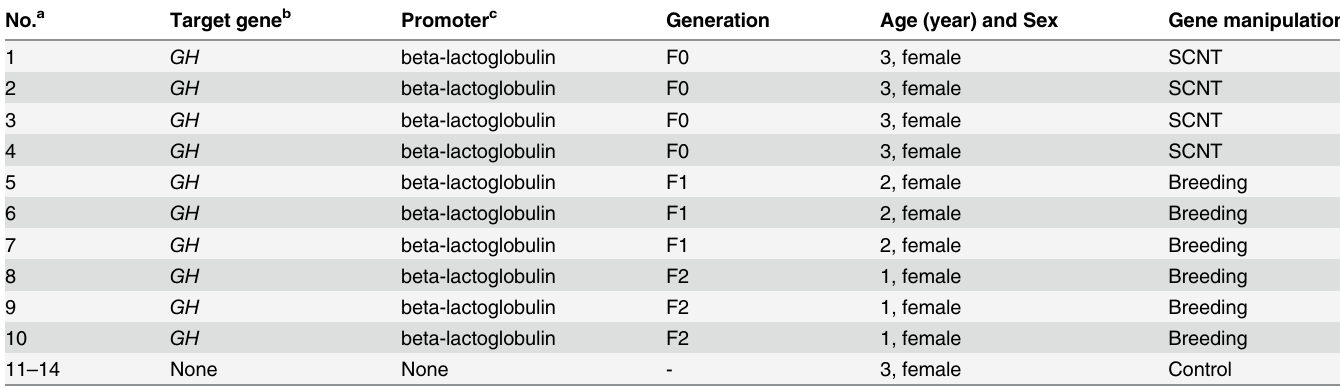
Table 1. Detailed information about the goats. No. a